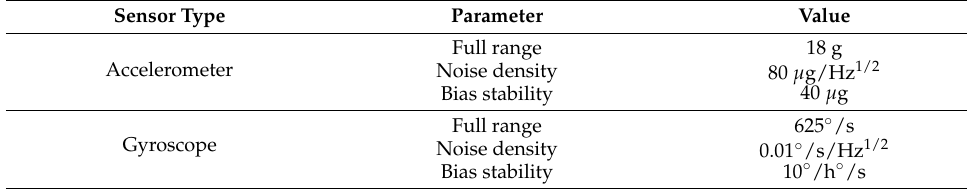
Table 2. Performance parameter of MTI-710.